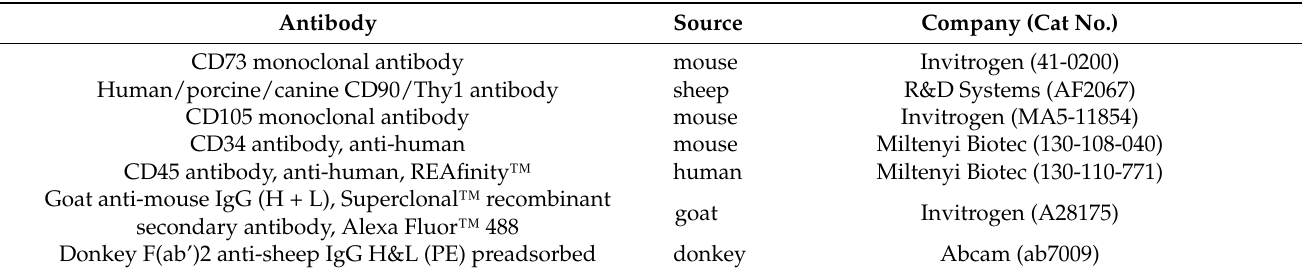
Table 3. List of antibodies for flow